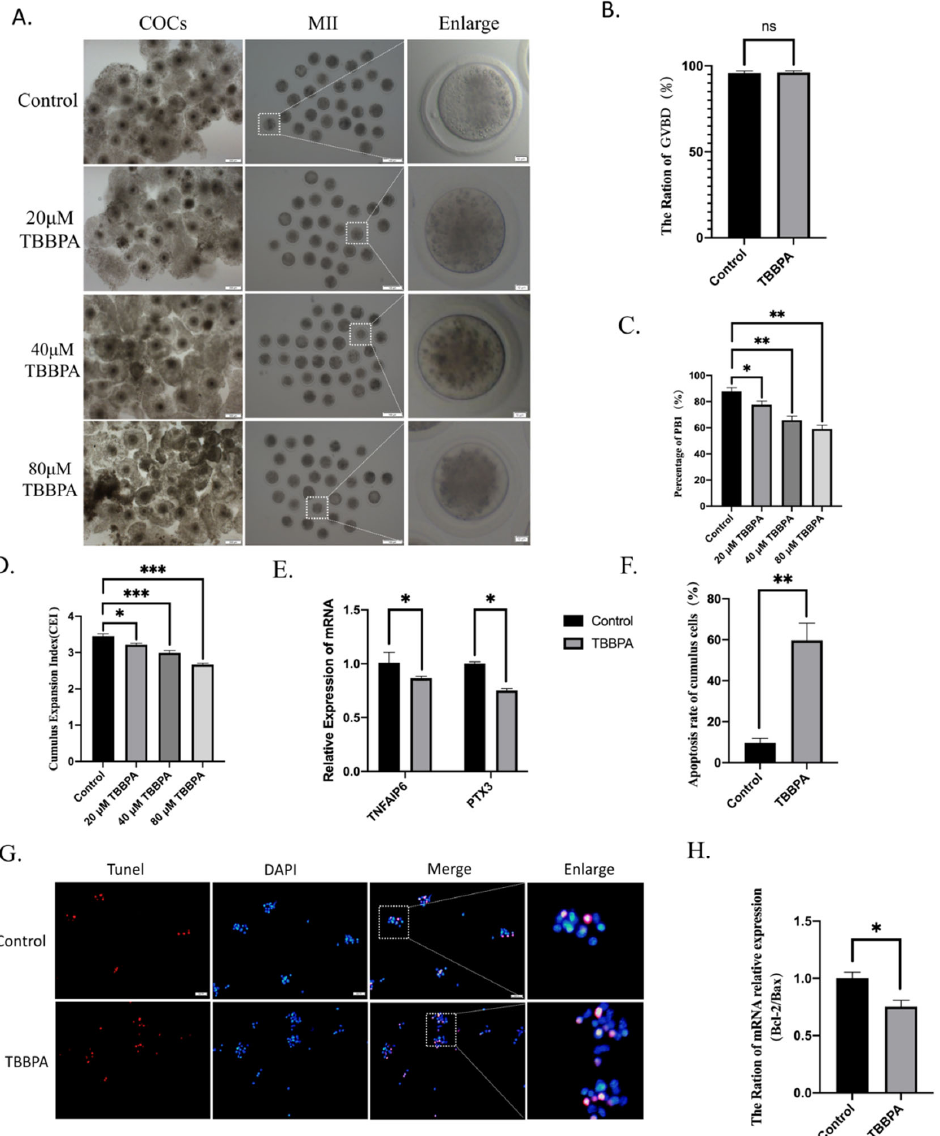
Figure 1. Effects of TBBPA exposure on bovine oocyte maturation: ( A ) Effects of TBBPA exposure on cumulus-cell expansion and polar-body extrusion in oocytes. COCs: scale bar = 200 µ m. Metaphase II (MII) oocytes: scale bar = 100 µ m. Enlarge: scale bar = 10 µ m. ( B ) Ratio of GVBD in each group. Control, n = 144; TBBPA, n = 152. ( B ) Polar-body extrusion rate in each group. Control, n = 179; 20 µ m TBBPA, n = 196; 40 µ m TBBPA, n = 173; 80 µ m TBBPA, n = 204. ( C ) The percentage of first polar-body extrusion was quantified in controls and groups with different concentrations of